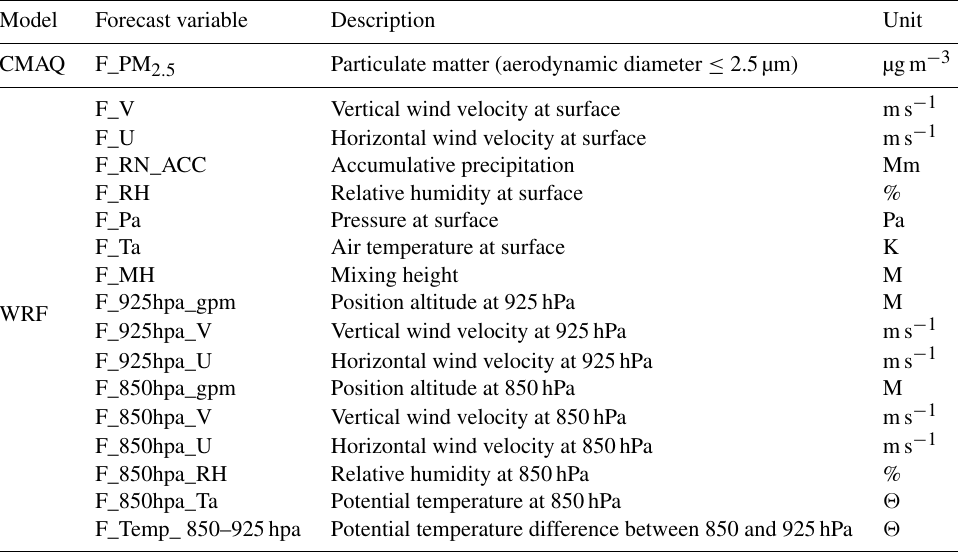
Table 2. Training variables in the PM 2 . 5 prediction system using a DNN based on the WRF and CMAQ models. WRF and CMAQ model results were obtained from 9km horizontal grid resolution. These values were collected on an hourly interval.